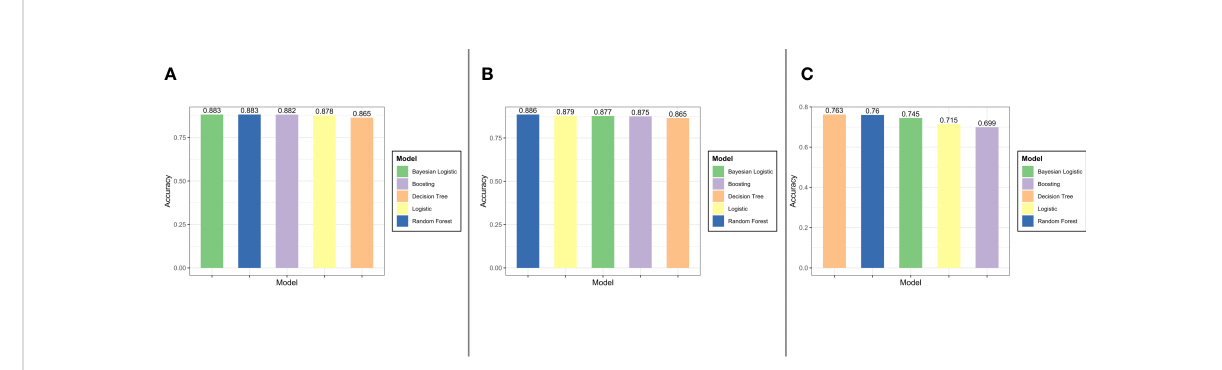
FIGURE 8 The result of models performance in the internal validation set, the external validation set 1, and the external validation set 2 (from (A – C)